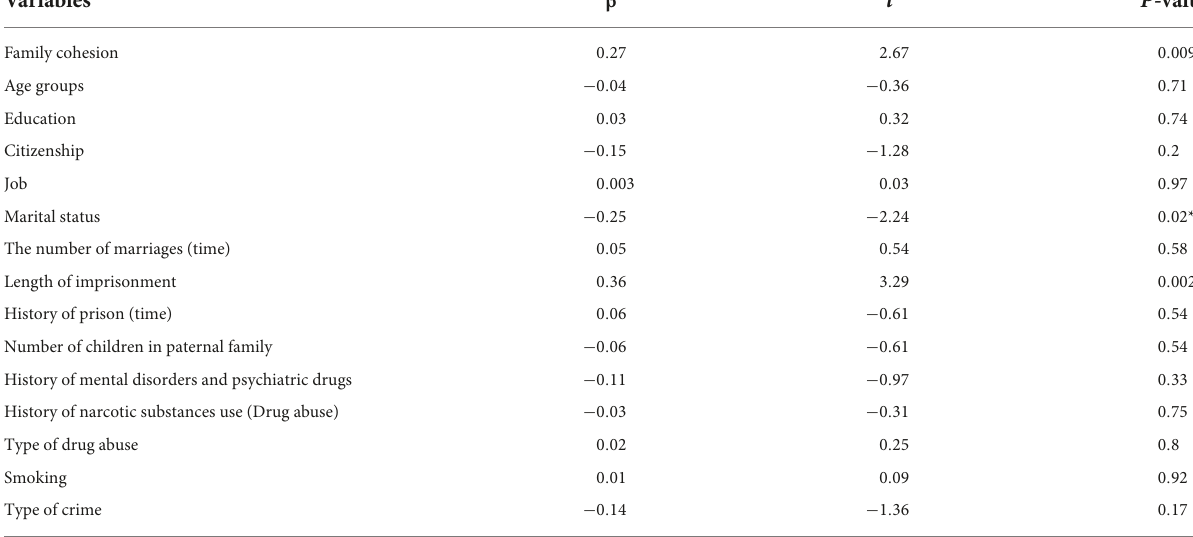
TABLE 4 Multivariate regression model for all variables and psychological